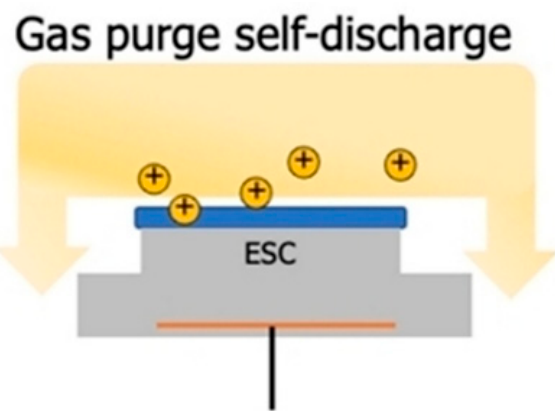
Figure 20. Gas purge discharge pressure during wafer de-chucking.